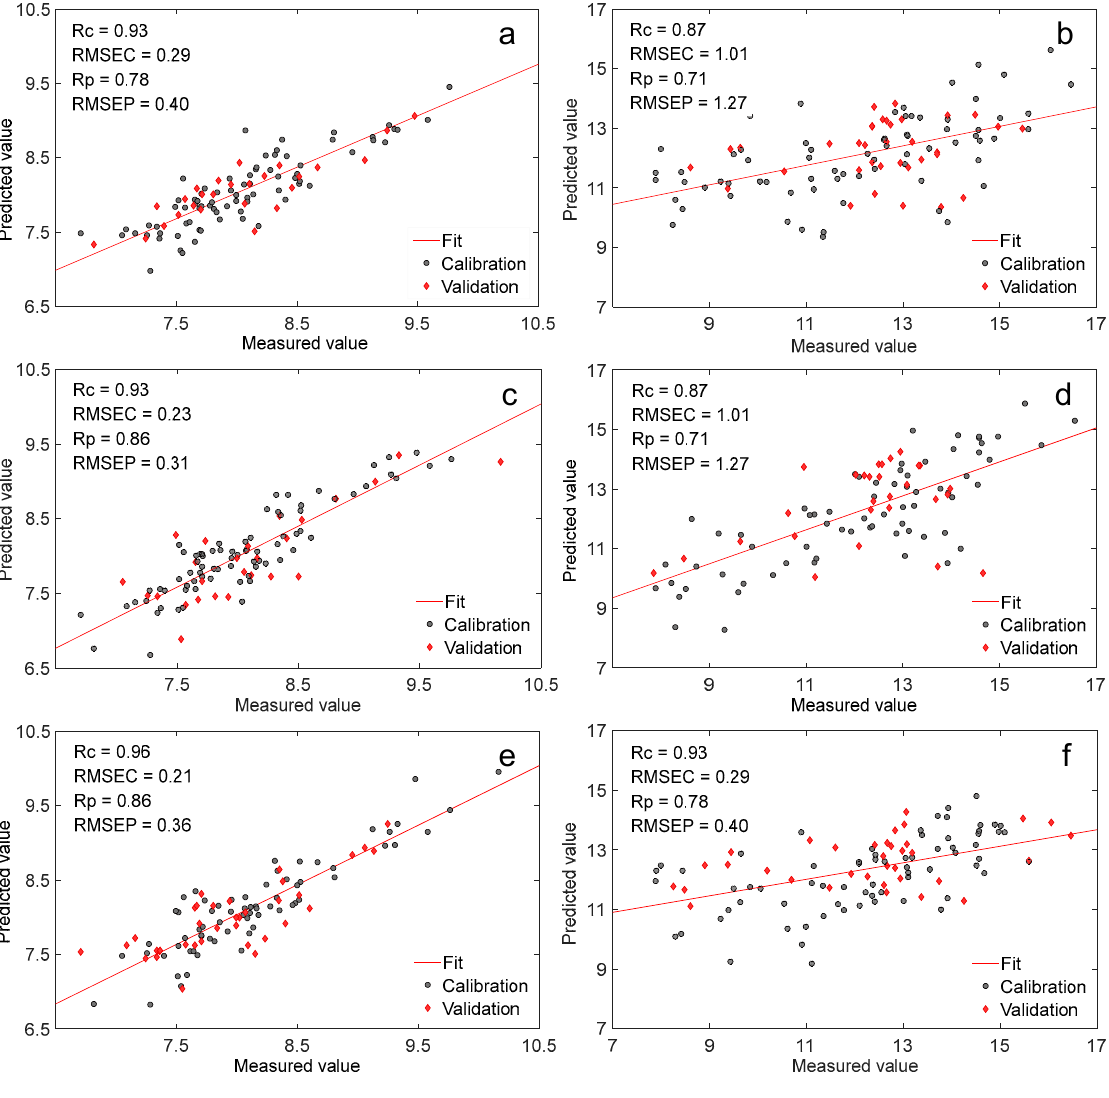
Figure 3. Scatter plots of crude protein and moisture models of forage maize for different NIR spectrometers (( a , c , e ) crude protein model of instrument A, B and C; ( b , d , f ) moisture model of instrument A, B, and C).